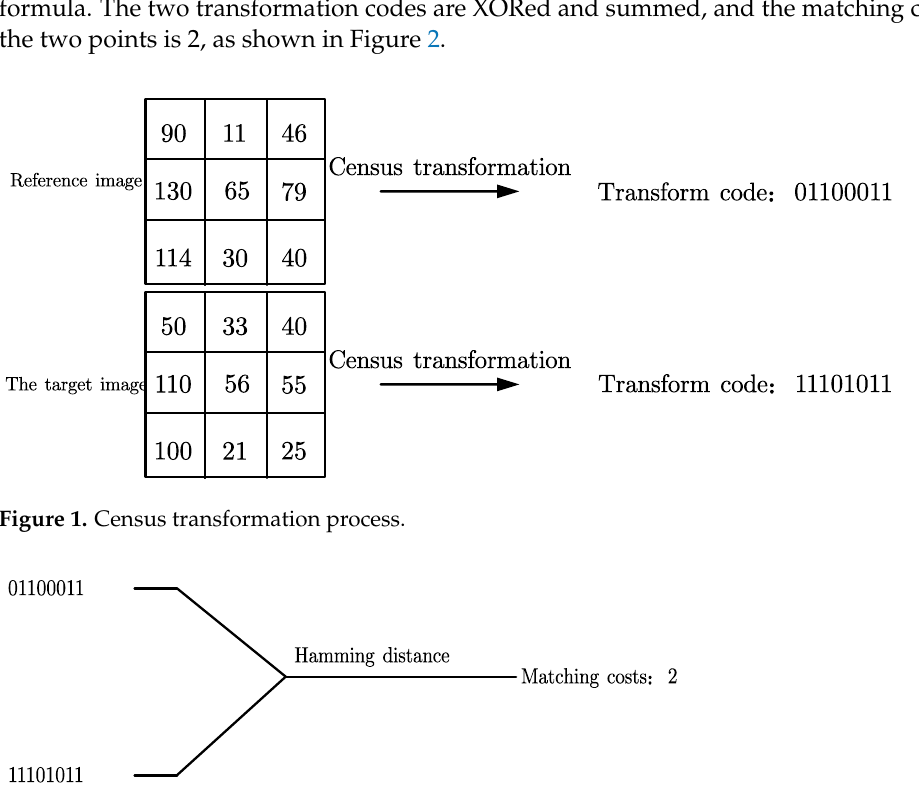
Figure 2. Hamming distance similarity detection.